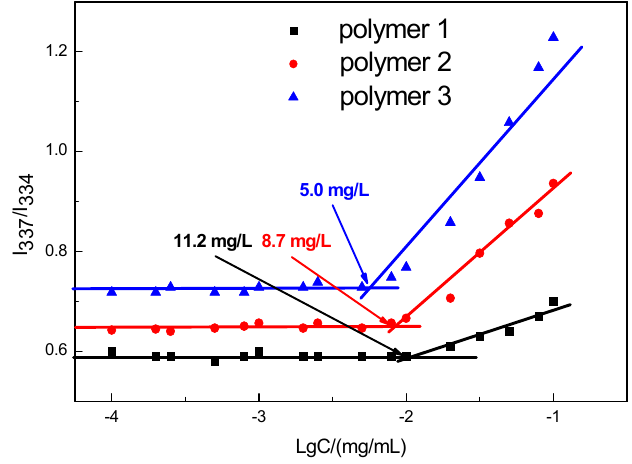
Figure 3. Self-assembled critical micelle concentration (CMC) of polymers 1, 2, and 3.